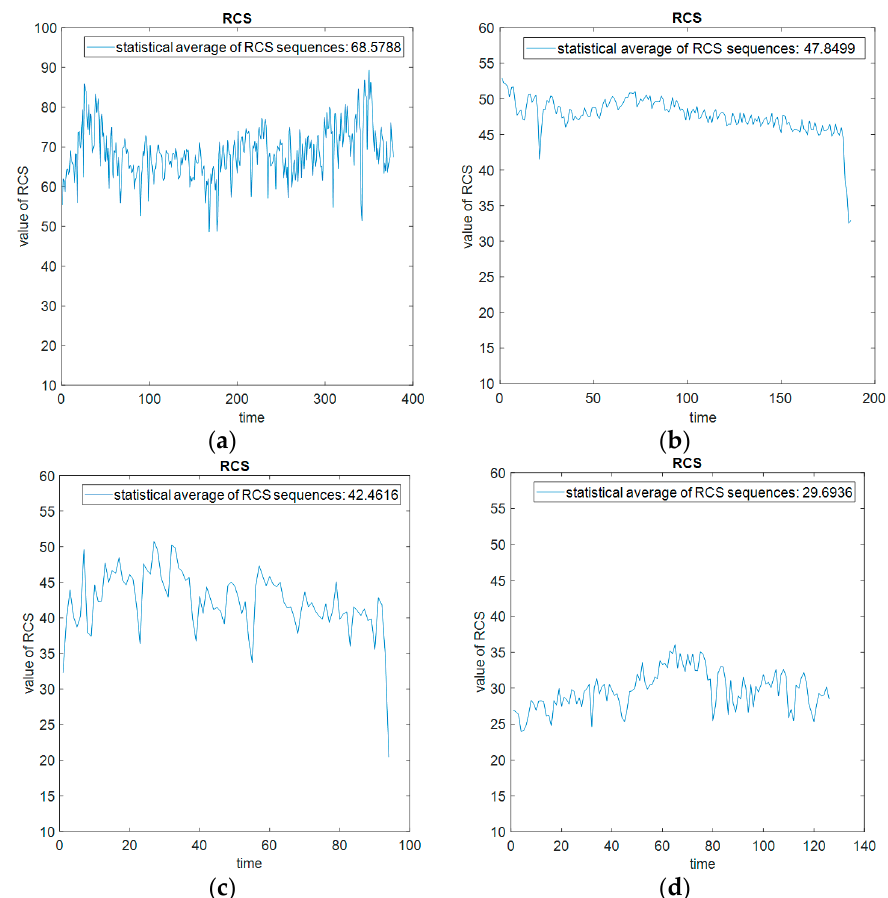
Figure 9. RCS sequences and respective statistical average of the measured data. ( a ) Helicopter. ( b ) Rotary-wing unmanned aerial vehicles (UAVs). ( c ) Fixed-wing UAV. ( d ) Bird.